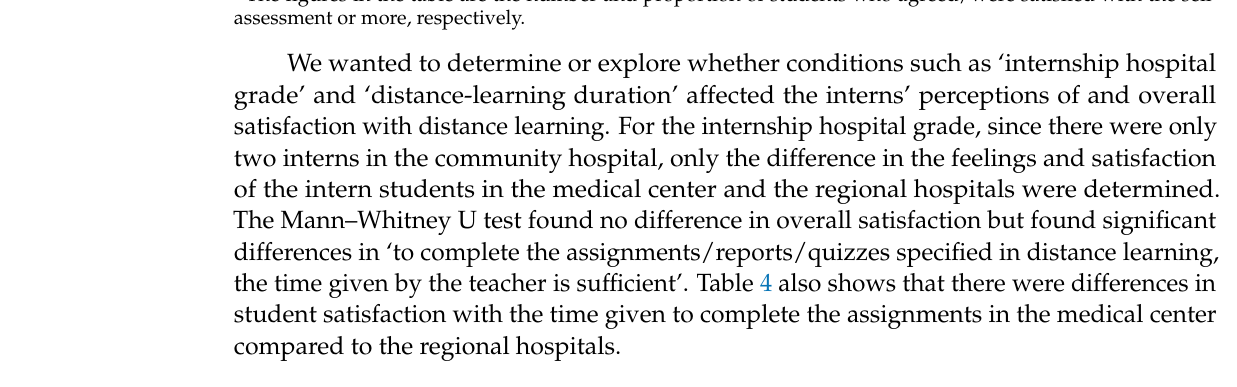
Table 4. Differences in the satisfaction levels of students between the medical center and the regional